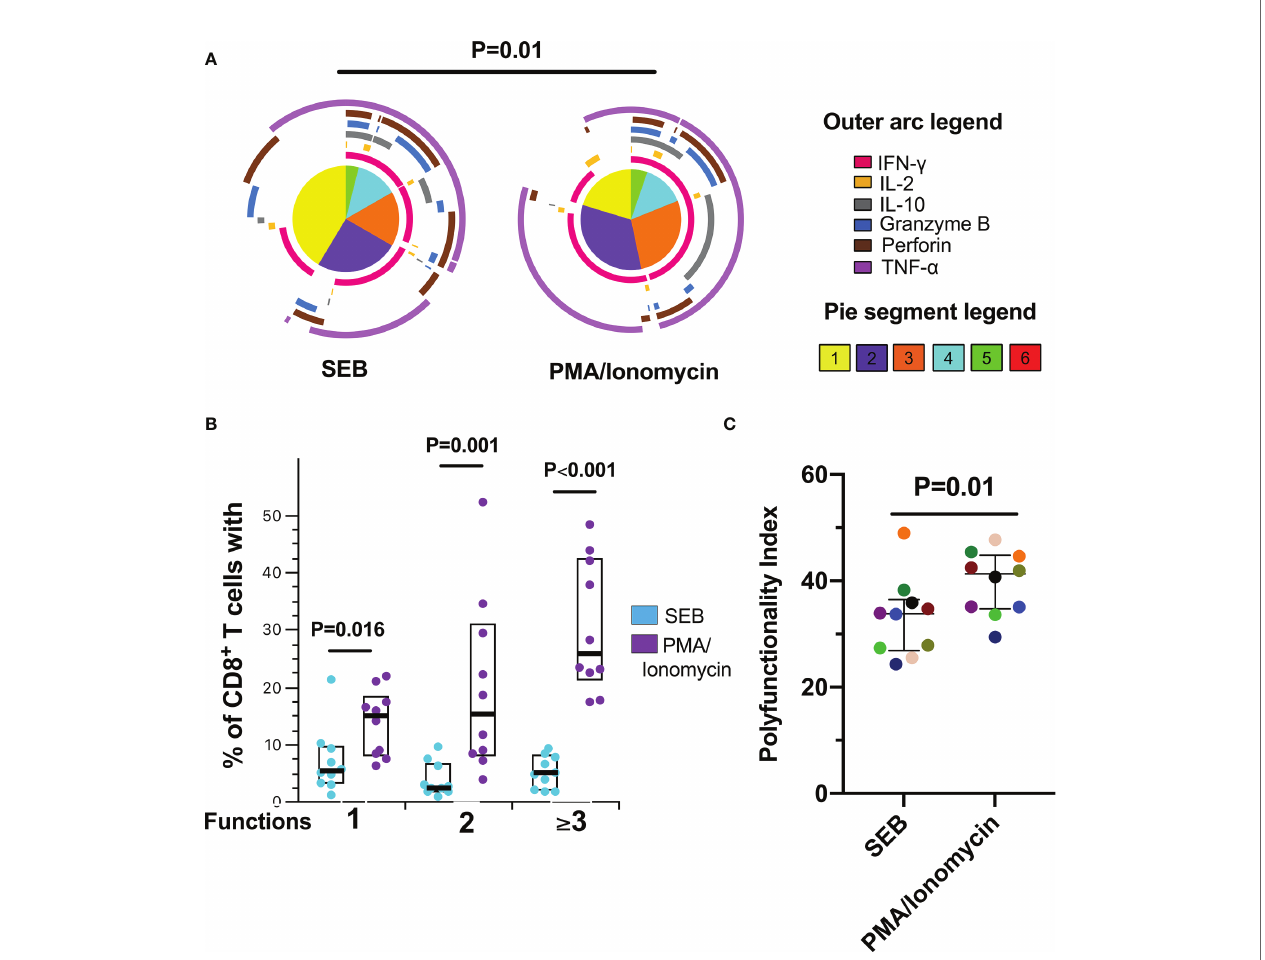
FIGURE 2 | Polyfunctional CD8 + T-cell response to polyclonal antigen-independent stimulation. (A) Pie charts represent the average frequencies of CD8 + T-cells cells secreting cytokines and cytotoxic molecules producing every possible combination of the six molecules analyzed after stimulation with Staphylococcal Enterotoxin B (SEB) and PMA/Ionomycin (PMA) for 12 hours SEB and PMA/Ionomycin. The segments within the pie chart denote populations producing different combinations of molecules (pie segment legend). The size of the pie segment correlates to the frequency of the particular population. The arcs around the circumference indicate the particular molecule (see outer arc legend) produced by the proportion of cells that lie under the arc. Parts of the pie surrounded by multiple arcs represent polyfunctional cells. (B) Percentage of cells exhibiting one, two, or more than three functions. (C) Polyfunctionality index. Wilcoxon test was used for matched-paired samples. Plots depict the median and IQR, n =